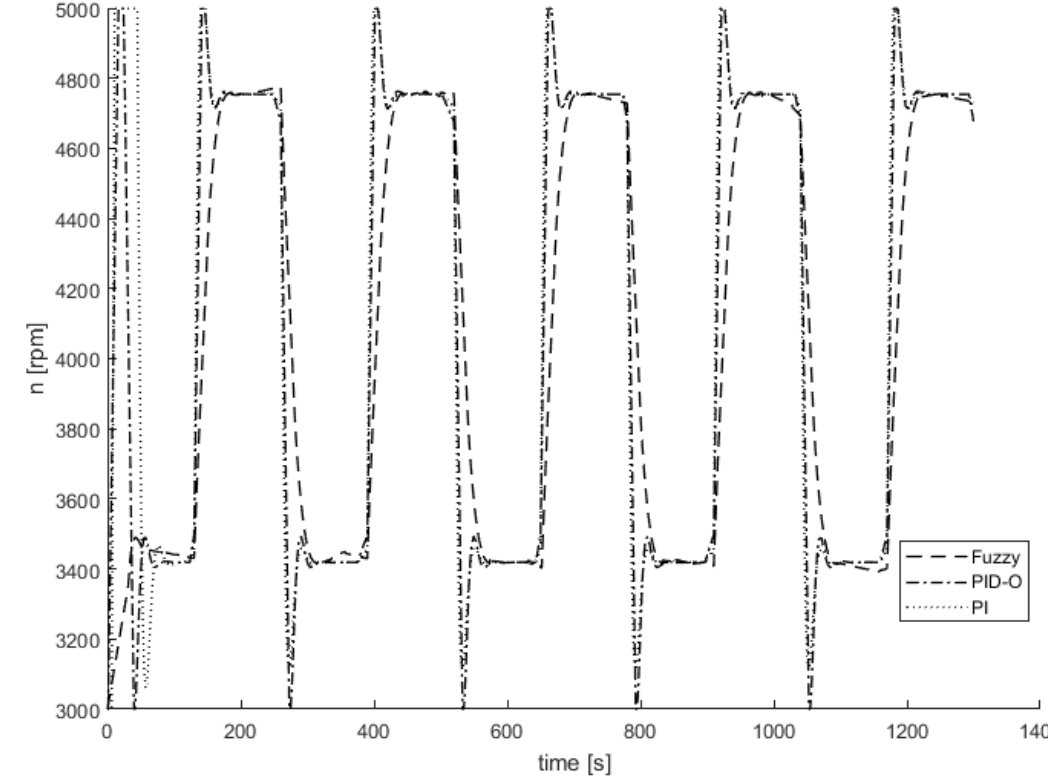
Figure 16. Comparison of control methods— n .